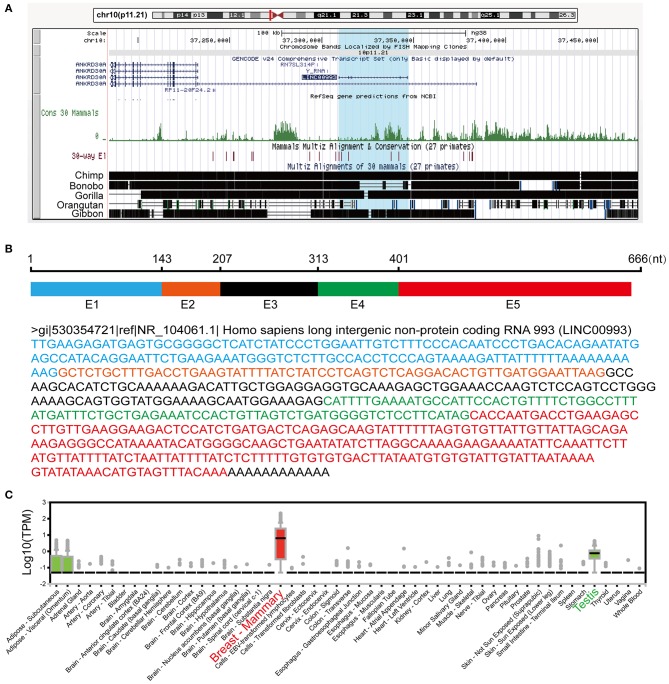
Information about LINC00993 from public websites. (A) Location of LINC00993 in human genome. Conservation of LINC00993 in multiple species. (B) Construction and sequence of LINC00993. (C) Detailed LINC00993 expression in different tissues shown by GTEx data.